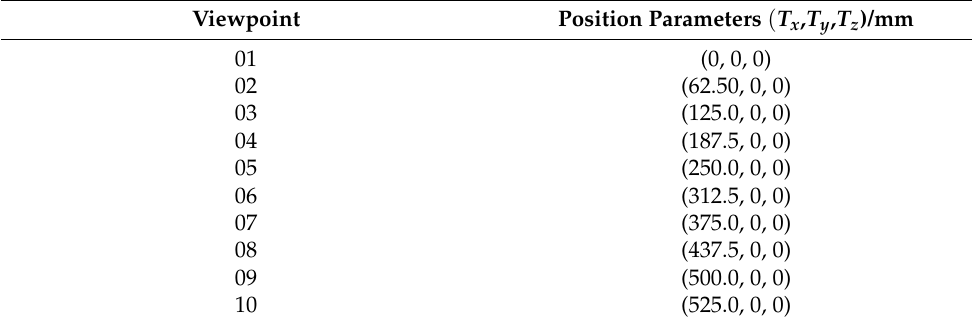
Table 1. The position parameters of the camera system for 1-by-10 views.